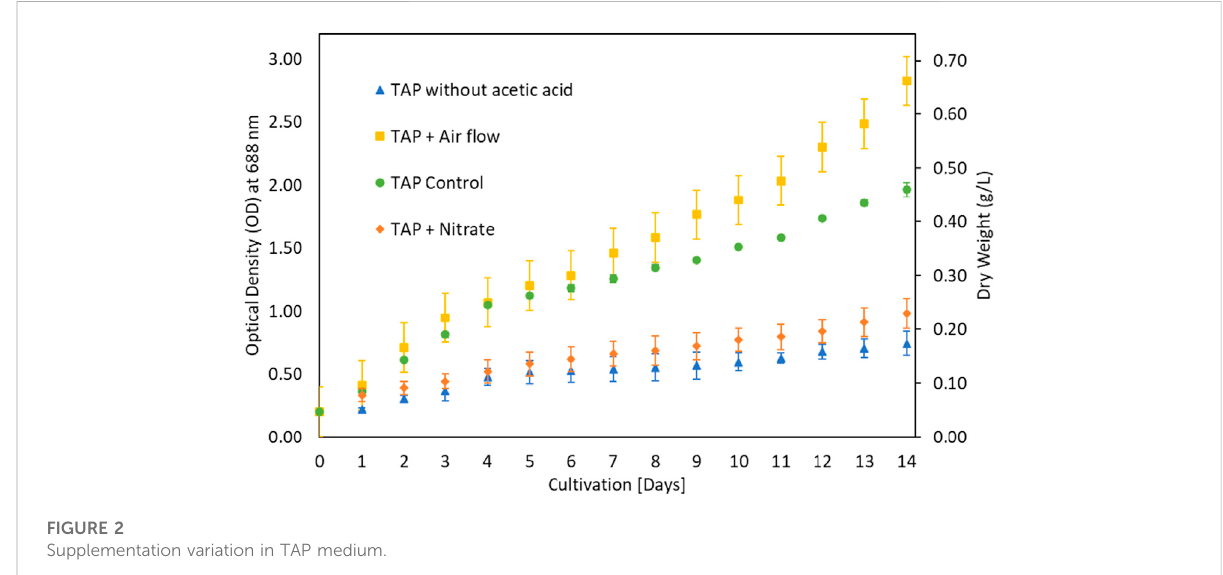
FIGURE 2 Supplementation variation in TAP medium.